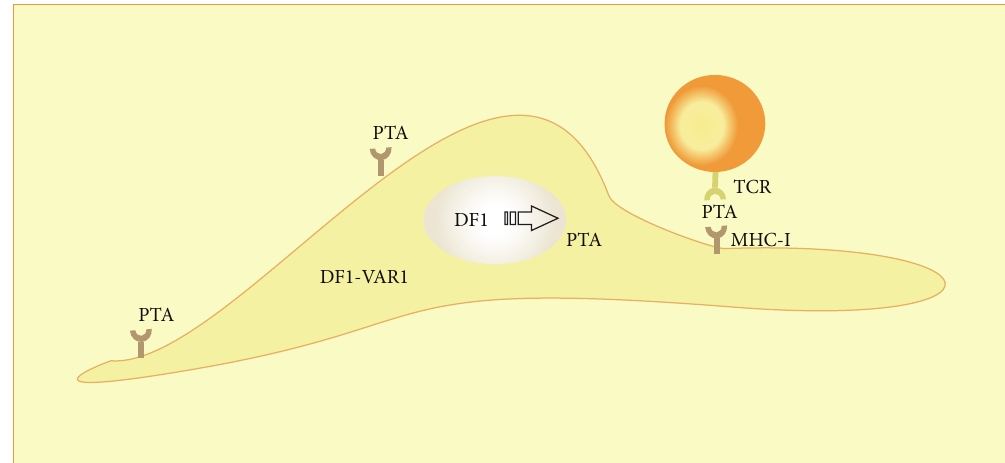
Figure 5: While the expression of AIRE by stromal cells is still a controversy, Turley et al. [14] suggest a role for DF1 and DF1-VAR1 isoforms of DEAF1, on PTAs expression by FRC and the peripheral